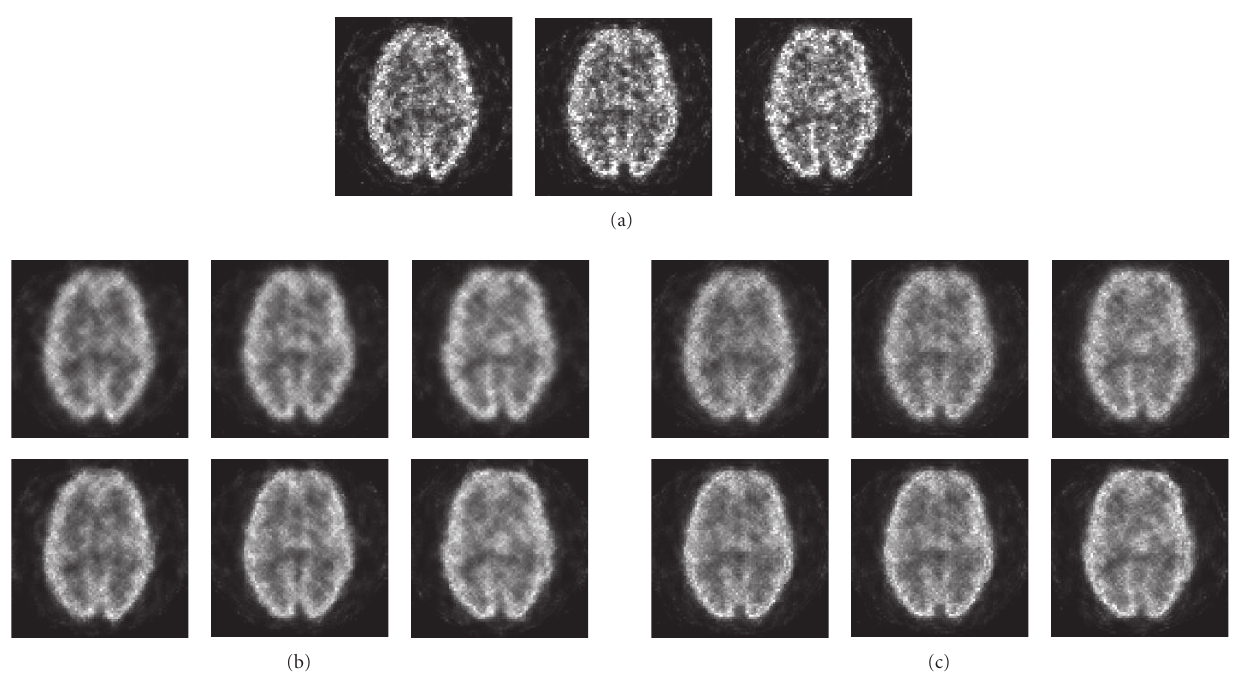
Figure 11: In (a), three (late-stopping) MLEM-reconstructed transaxial slices of the Ho ff man phantom. In (b), radial sinogram filtering: MLEM images for Gaussian filtering (top row) and for L-filtering (bottom row) at the matched resolutions (see Figures 4 and 5). In (c), angular stackgram filtering: MLEM images for Gaussian filtering (top row) and for L-filtering (bottom row) at the matched resolutions (Figures 4 and 5). All images share a common